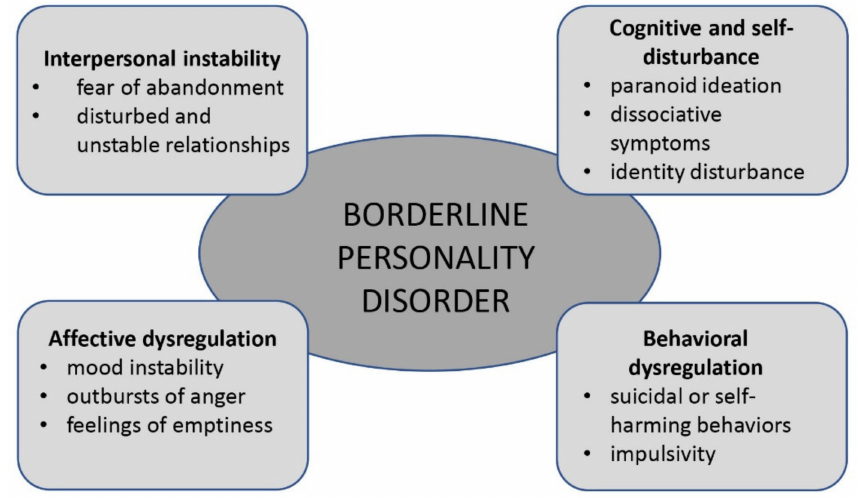
Figure 1. Adapted from Gunderson et al.